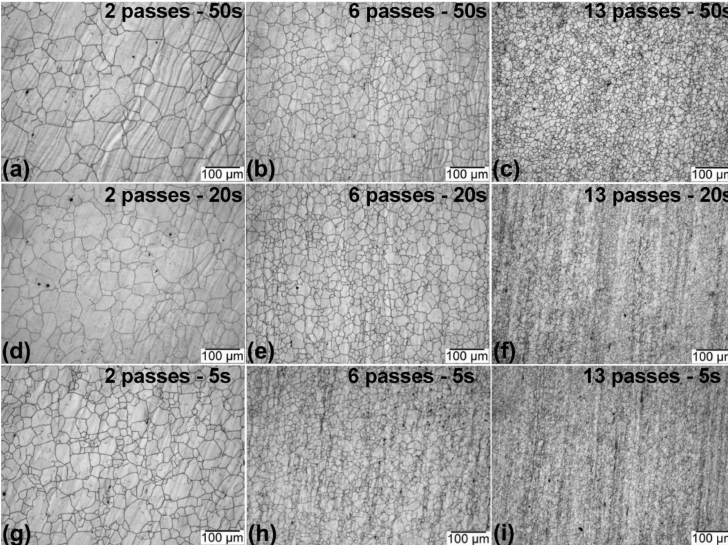
Figure 4. ( a ) 2 passes—50 s, ( b ) 6 passes—50 s, ( c ) 13 passes—50 s, ( d ) 2 passes—20 s, ( e ) 6 passes—20 s, ( f ) 13 passes—20 s, ( g ) 2 passes—5 s, ( h ) 6 passes—5 s, ( i ) 13 passes—5 s. Optical micrographs